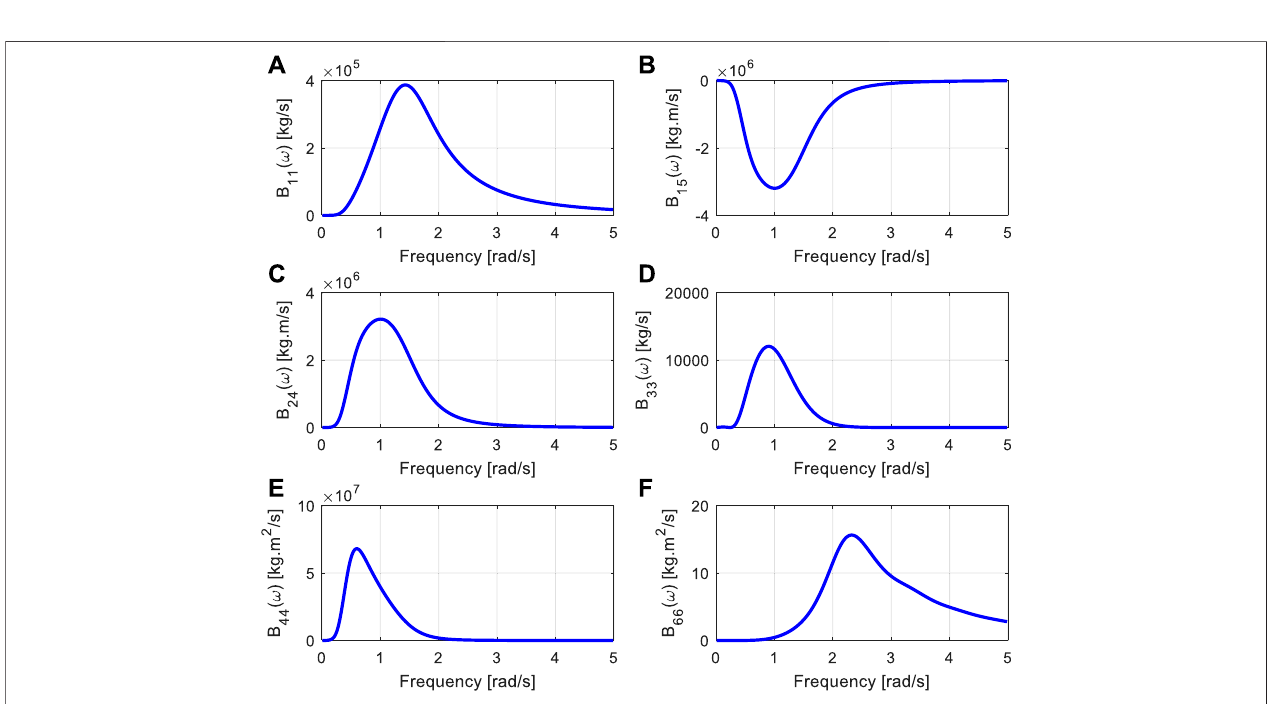
FIGURE 3 | Frequency-dependent damping of fl oating offshore wind turbines. (A) B11(w); (B) B15 (w); (C) B24(w); (D) B33(w); (E) B44(w) and (F) B66(w).